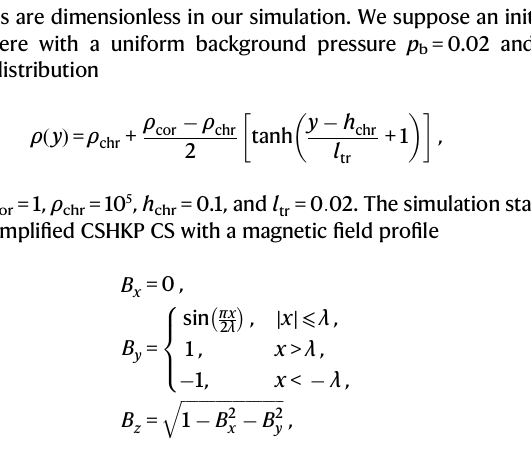
Fig. 6 | Quasi-periodic characteristics of synthetic SXR variation. a Temporal evolution of the SXR emission power at 1 – 8Å, P SXR . b Temporal evolution of the time derivative of P SXR , d P SXR /d t . c The wavelet power spectrum of the temporal evolution of d P SXR /d t . Same as in Fig. 3, the gray shading denotes the cone of in fl uence(COI),and theblackcontoursenclosethe regionswherethe global(solid